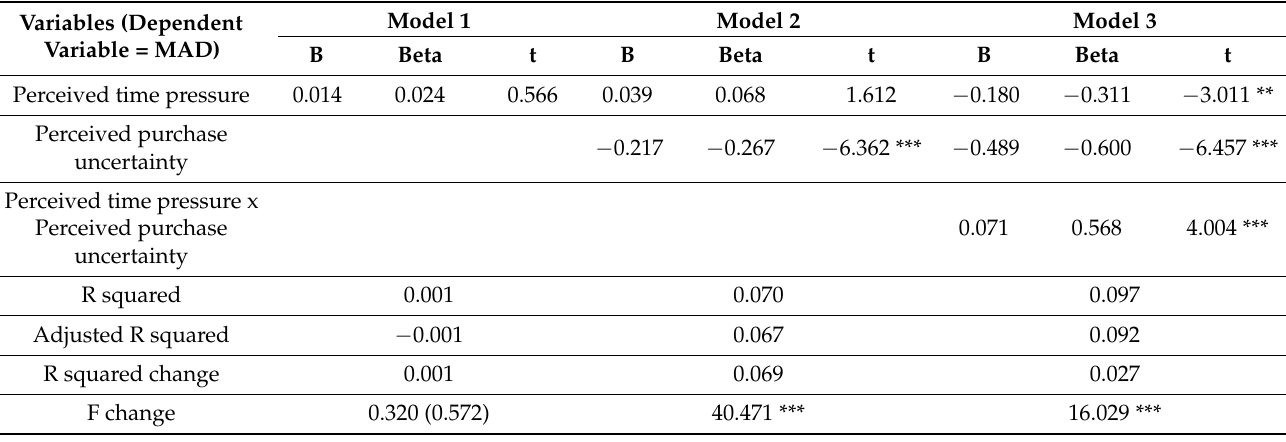
Table 5. Moderating effects of pre-search uncertainty with hierarchical regression for interaction (moderation)